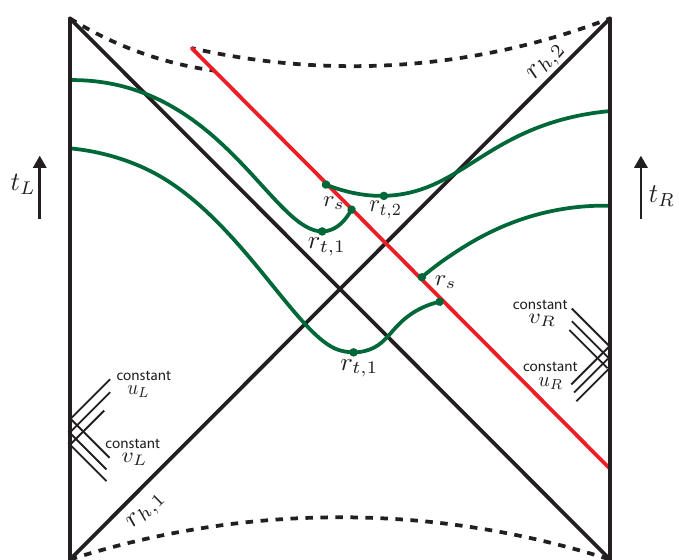
Figure 13. Illustration of maximal volume surfaces in the shock wave geometry. Some special points are indicated in the drawing: r t; 1 the turning point in BH 1 (if it exists), r t; 2 the turning point in BH 2 (if it exists) and r s the point in which the maximal volume surface crosses the shell. We have also indicated in the (cid:12)gure lines of constant u and v induced from either boundary as well as the direction of the time coordinates on the left and right